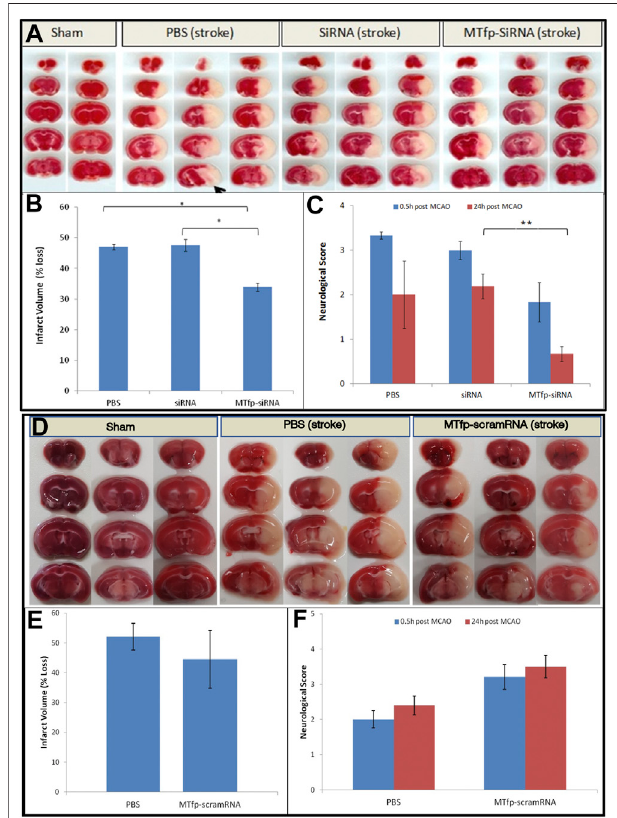
FIGURE 4 | Top panel. (A – C) : Treatment with MTfp-siRNA confers neuroprotection and reduces damage after ischemic stroke. (A) TTC-stained brain sections of mice receiving various IV injections, followed by ischemic stroke. Tissue was collected 24 h after surgery (B) Infarct volume was quantitated by measuring absorbance of solvent extracted dye (* p < 0.05, one-way ANOVA). (C) Neuroscore at 0.5 and 24 h after stroke induction in mice pretreated with siRNA, MTfp-siRNA or PBS control. * p < 0.05, ** p < 0.001. Bottom Panel (D – F) : Treatment with MTfp-scrambled RNA does not offer neuroprotection after ischemic stroke. (D) TTC-stained brain sections of mice receiving various IV injections, followed by ischemic stroke. (E) Infarct volume was quantitated by measuring absorbance (485 nm) of solvent extracted dye. Data are shown as mean ± SEM (no signi fi cant difference). (F) Neuroscore at 0.5 and 24 h after stroke induction. Data are shown as mean ± SEM (There is no signi fi cant difference between the treatments at either time point) ( n (cid:2) 3 mice per